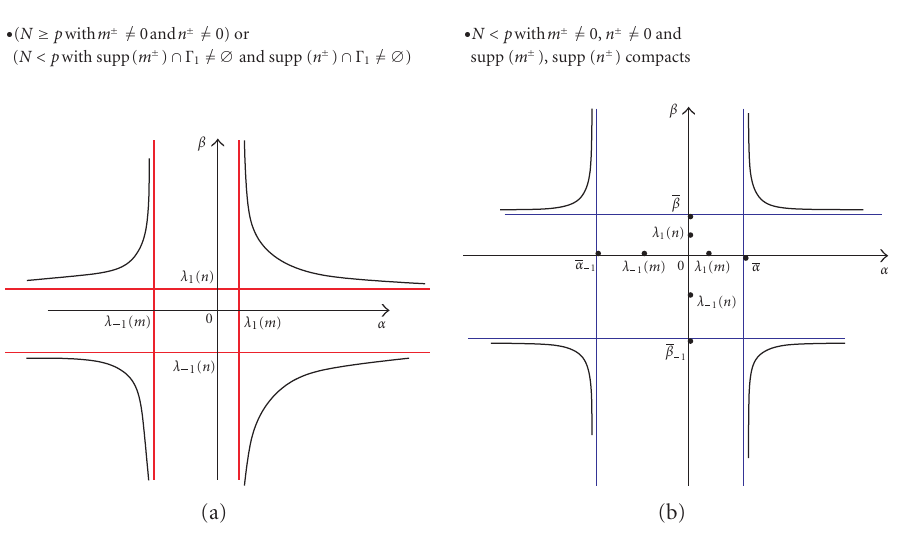
Figure 5.1 . Mixed Fuˇcik spectrum with